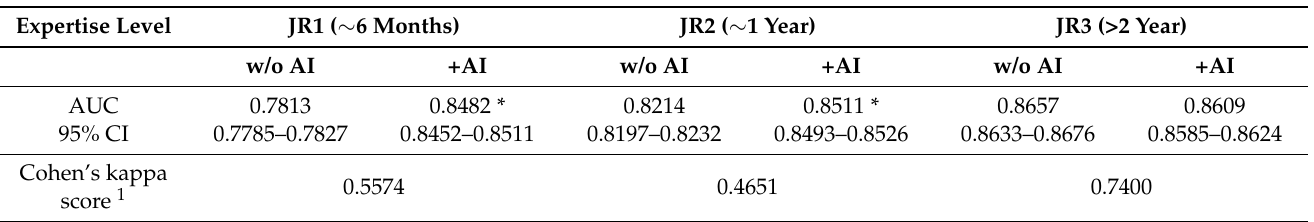
Table 4. Performance comparison of JRs and JRs+AI for the external test set in terms of AUC score, 95% confidence interval (95% CI), and Cohen’s kappa score.